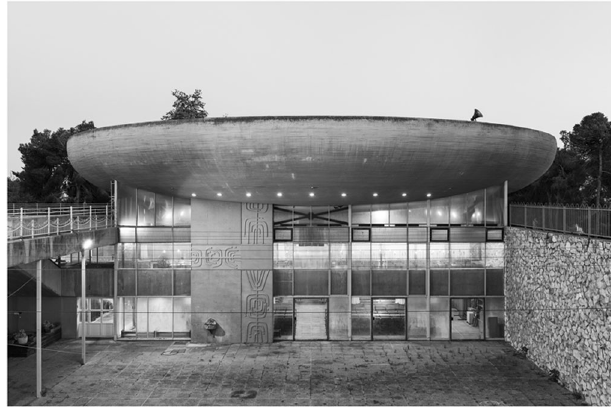
Fig. 4 The Central Synagogue of Nazareth Illit. Architect Nahum Zolotov, 1968 (Photo: Eli